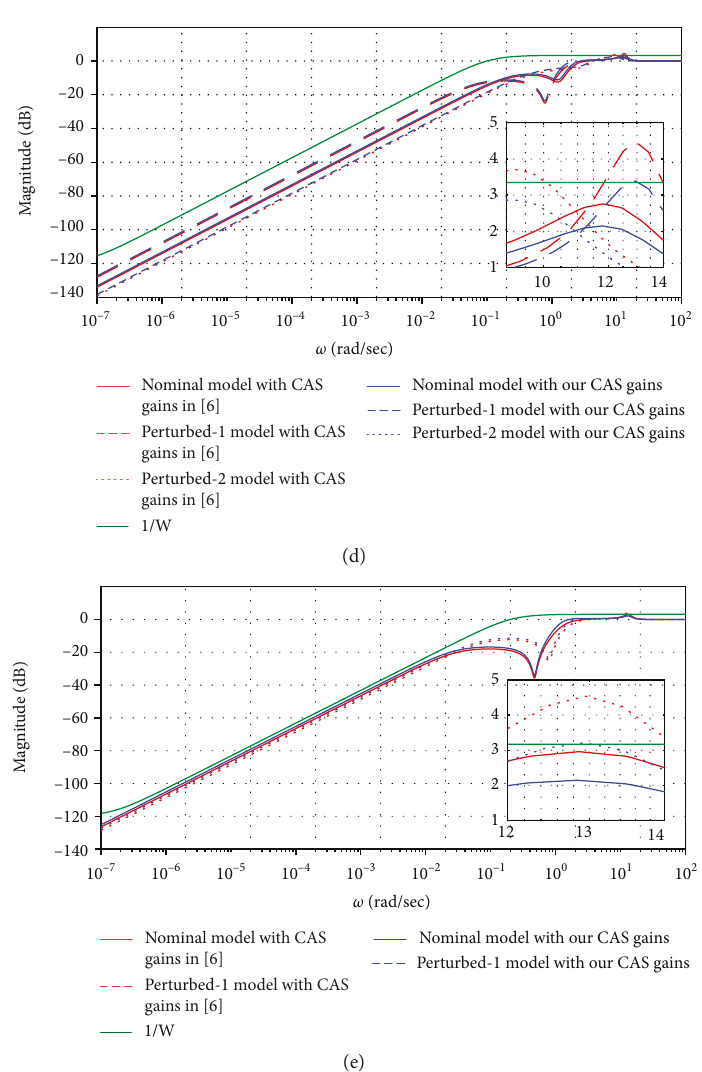
Figure 7: Gain plots of closed-loop sensitivity functions using CAS gains in [6], optimized gains in Table 2, and 1/ ∣ W s ∣ in each design points. (a) Clean, (b) T00, (c) T15, (d) T70, and (e) T90. (close-look fi gures at maximum peak gains are given in the